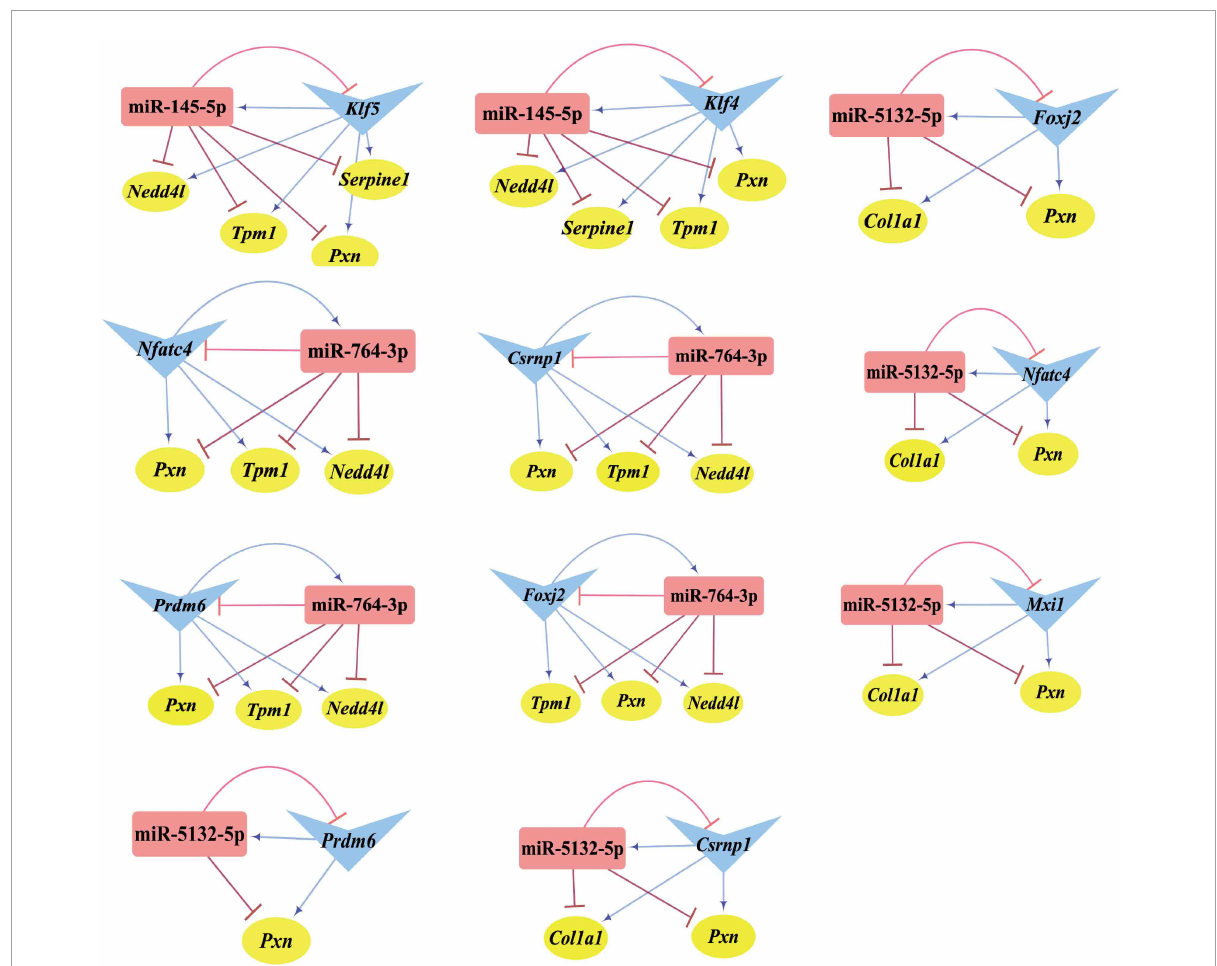
FIGURE9 Composite loops among key miRNAs, TFs, and genes. Collection of composite loops of key nodes based on mutual regulatory miRNA-TF pairs. The gene, miRNA, and TF are represented with yellow circles, red rectangles, and blue triangles, respectively. The terminal of the edges radiating from the miRNA is marked in red and T-type blunt arrow, while the one that changed to sharp arrow for the edges radiated from TF is in blue